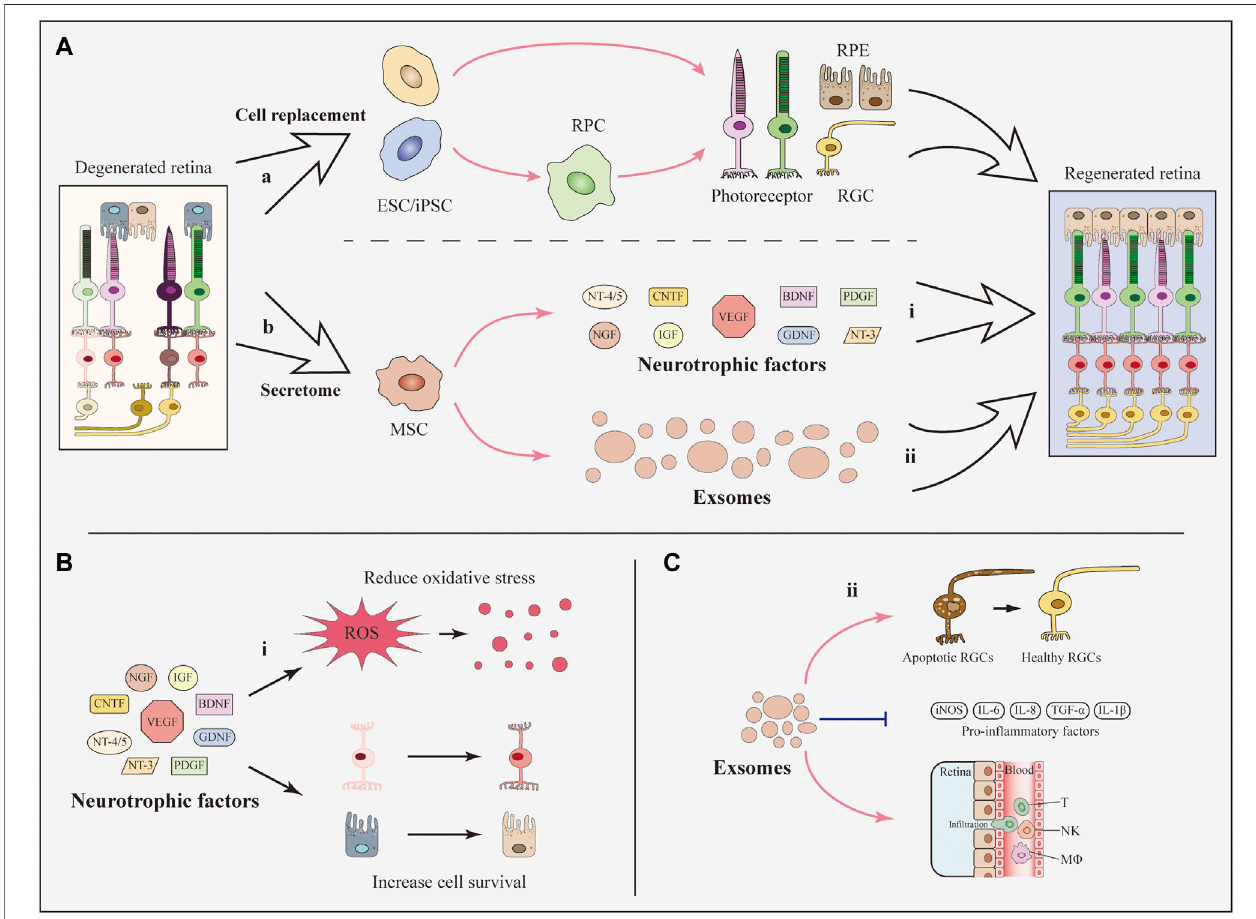
FIGURE 1 | Basic approaches of SCT to develop therapeutic effects. (A) Basically, stem cells contribute to the retinal recovery through two approaches: Cell replacementand thesecretome. (i) iPSCs, ESCs,and RPCs candifferentiate intoretinal cellsincluding RGCs andphotoreceptorsand canbeused forcellreplacement. (ii) MSCs secret neurotrophic factors and exosomes which are bene fi cial for the recovery of regenerated retina. (B) Neurotrophic factors contribute to the reduction of oxidativestressand thesurvivalof retinal cells. (C) MSC-derived exosomes prevent the decline of RGCs and reduce theexpression ofin fl ammatoryfactors aswell as the in fi ltration of in fl ammatory